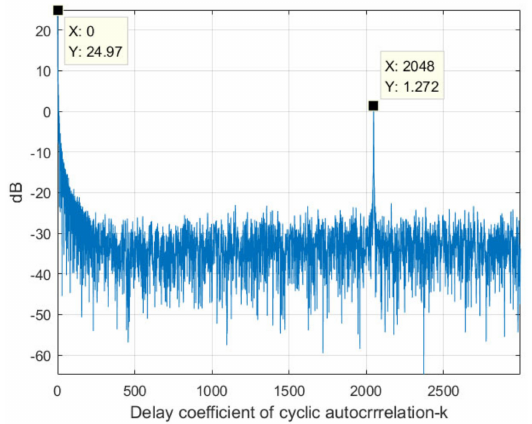
Figure 5. CAC result of a simulated LTE